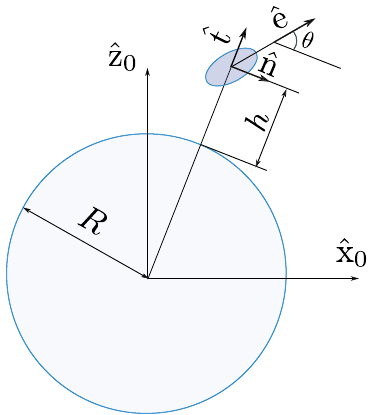
Fig. 6 Graphical illustration of a microswimmer moving near a spherical boundary. Here, ^ x 0 and ^ z 0 are the unit vectors of the system of Cartesian coordinates, R denotes the radius of the spherical obstacle, ^ e is the instantaneous orientation vector of the swimmer, ^ n and ^ t are unit vectors in the microswimmer ’ s frame of reference, θ is an inclination angle, and h de fi nes the distance between the microswimmer and the